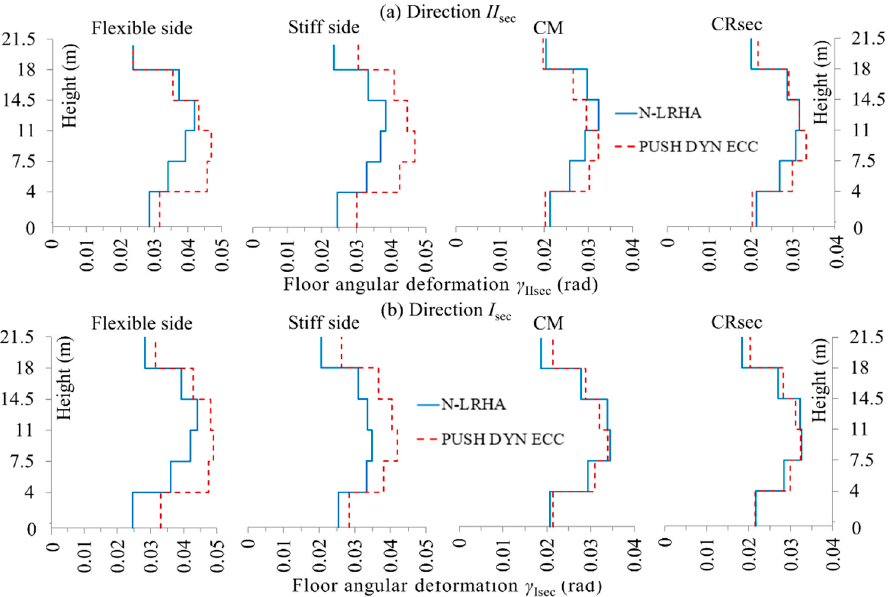
Figure 14. Floor angular deformations (rad) of case 2 building at NC: ( a ) γ IIsec along the II sec axis, ( b ) γ Isec along the I sec axis. Proposed pushover procedure vs.